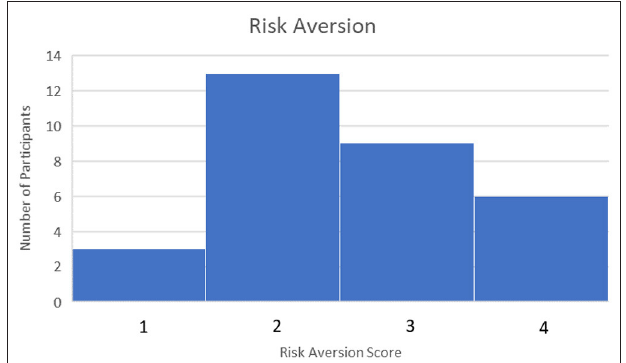
FIGURE 7 | Risk aversion